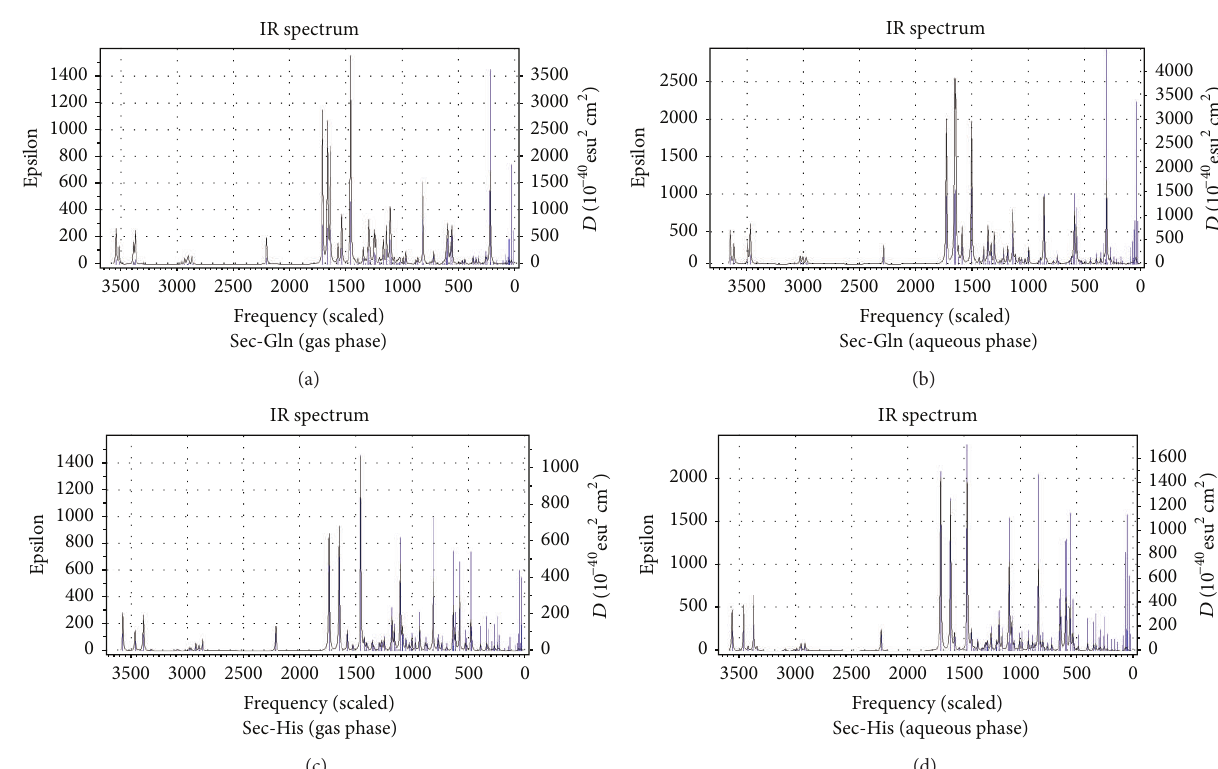
Figure 5: Vibrational spectra of Sec-Asp and Sec-Ser in gas and aqueous phase.